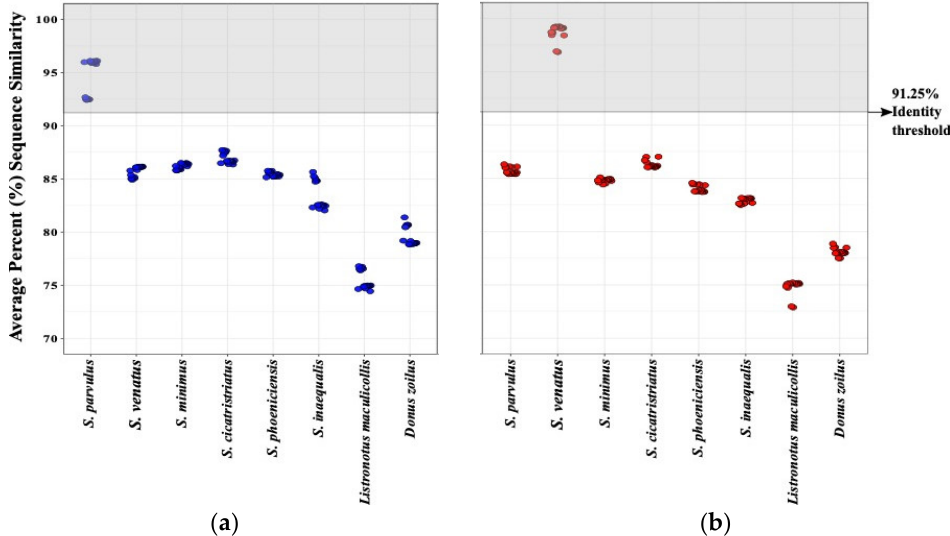
Figure 4. Pairwise distances between adults measured as average percent sequence similarity of the COI gene (640 bp) show successful species identification above a 91.25% similarity threshold—a visual representation of the method for comparing unknown samples to a reference DNA barcode database for species identification. Graph ( a ) depicts Sphenophorus parvulus specimens collected from several locations (blue dots) and graph ( b ), S. venatus specimens collected in several locations (red dots). To calculate average percent sequences similarity, each individual sequence from S. parvulus ( a ) or S. venatus ( b ) was compared to all other sequences in our reference database: S. parvulus , S. venatus , S. minimus , S. cicatristriatus , S. phoeniciensis , S. inaequalis , Listronotus maculicollis and Donus zoilus . The area in gray highlights the range of sequence similarity above the 91.25% threshold used for species identification. Data points falling above the threshold value (in grey area) are assigned to the species shown below on the x-axis. Table 3. Summary of larval specimens collected at Utah 2018 and Indiana 2020 in cool- and warm-season turfgrass. The total number of each species identified at each location and type of grass (* cool-season or ◦ warm-season) is included.